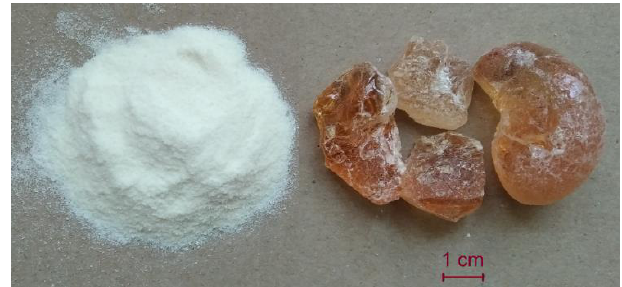
Figure 1. Gum arabic in the form of powder and crystals. The recipe symbols and their composition are presented in Table 1. The number in the lime-metakaolin paste (LM) symbol means the percentage of gum arabic (GA) in rela- tion to the binder weight (hydrated lime + metakaolin). Table 1. Components of the tested pastes. Recipe Symbol